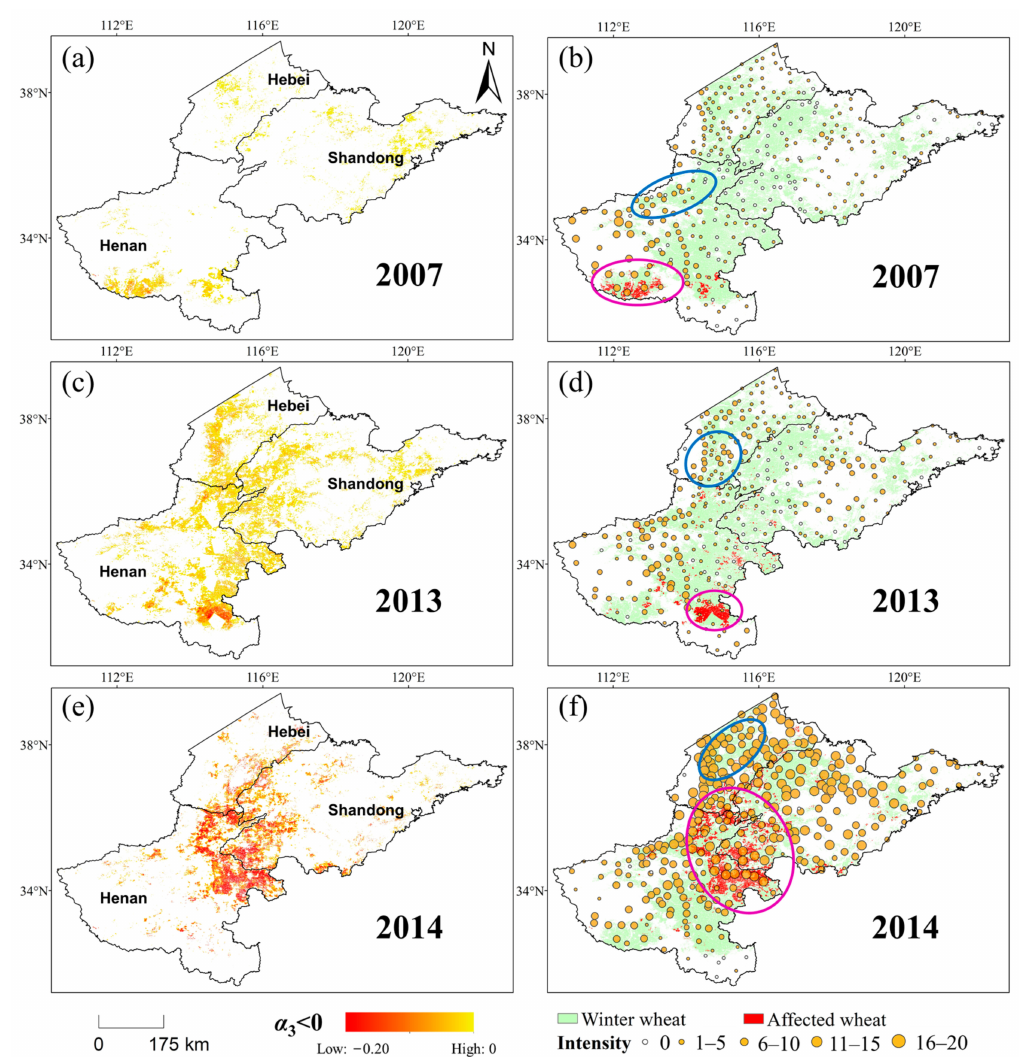
Figure 6. The NDPI loss derived from the DID-based method and the corresponding meteorological intensity of dry-hot wind hazard for the year of 2007 (mild, ( a , b )), 2013 (moderate, ( c , d )), and 2014 (severe, ( e , f )). The green shaded pixels in ( b , d , f ) represent the wheat-growing area based on the resampled crop type map. The area marked by red color in the second column shows the area with statistically significant NDPI loss (i.e., significant negative α 3 , using t -test) based on the DID method. Each point in the second column represents a site with the size corresponding to the intensity of dry-hot wind for that year calculated from the meteorological records. Red circles in ( b , d , f ) indicate that the spatial distribution of the significantly affected wheat area is consistent with the distribution of sites with a higher meteorological intensity of the hazard. However, blue circles indicate that their spatial distribution is